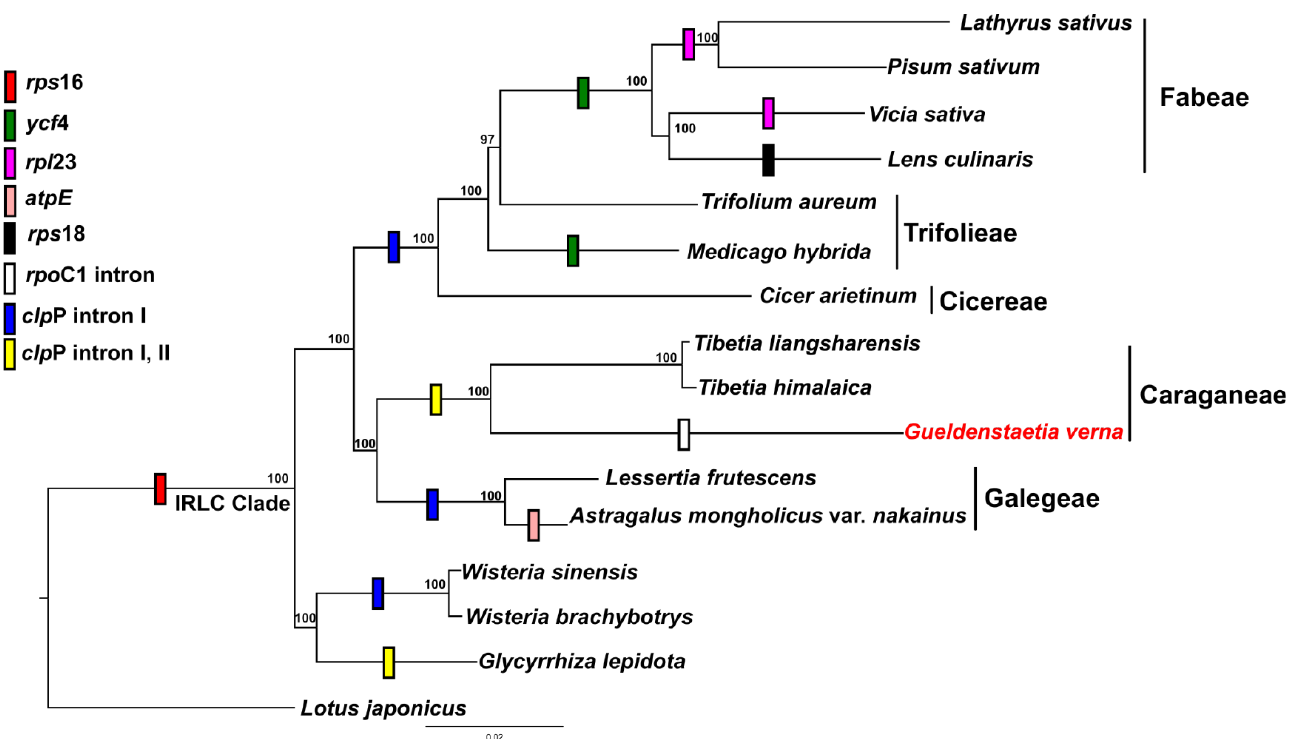
Figure 3. The maximum likelihood tree constructed using 67 protein-coding genes from 19 species. The colored boxes indicate loss of the gene or intron.